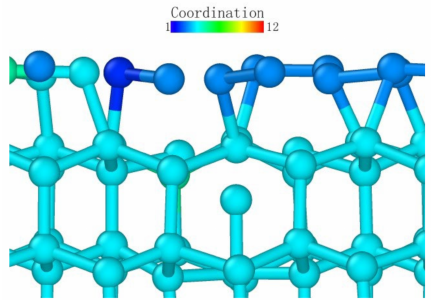
Figure 25. Atomic transient state at 0.39 nm loading